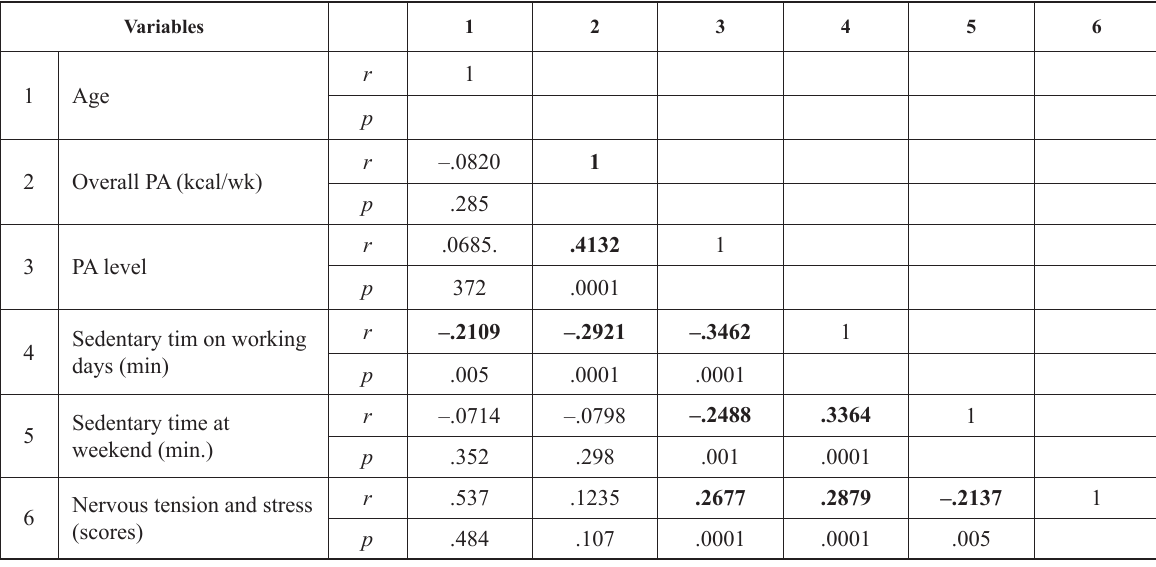
Table 4. Relationship between overall physical activity, sedentary time on weekdays and at weekends, and psycho-emotional state